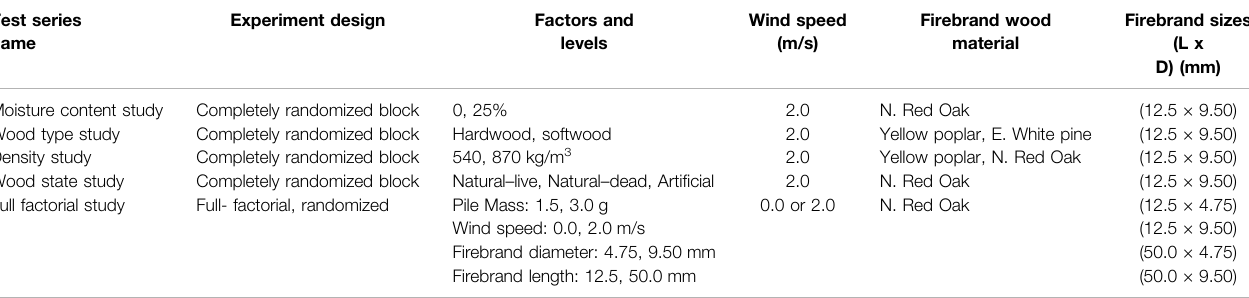
TABLE 1 | Tests used to evaluate the impact of eight factors on heat transfer from fi rebrand